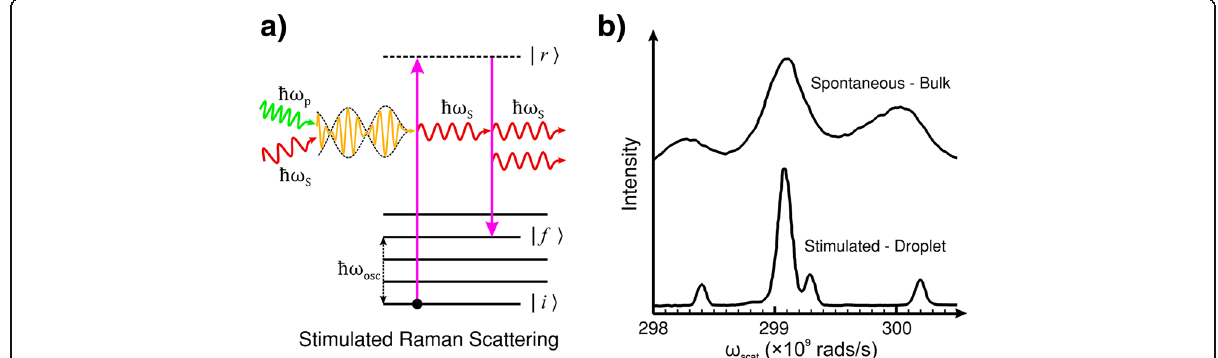
Fig. 2 a Energy level diagram of stimulated Raman scattering (SRS). SRS is the induced emission of Stokes light by the coherent interaction of the pump and Stokes light with the material. Unlike spontaneous Raman scattering where the lifetime of the state |r 〉 and the energy of the final state |f 〉 are probabilistic, in SRS, the (ro-)vibration of the molecule or lattice is coherently driven by the difference frequency of the pump and Stokes light. b Comparison of spontaneous Raman scattering and SRS of bulk and droplet ethanol. The spontaneous measurements were performed in a cuvette (bulk ethanol). The SRS measurements were performed in a droplet of ethanol which acted as an optical resonator for the Stokes light. b reproduced with permission from the OSA